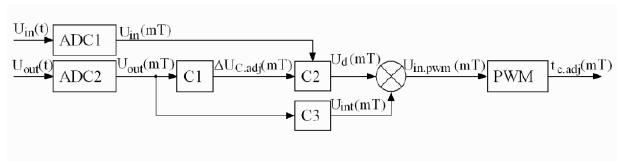
Figure 4. The block diagram of the signal processing sequence performed by the microprocessor control system